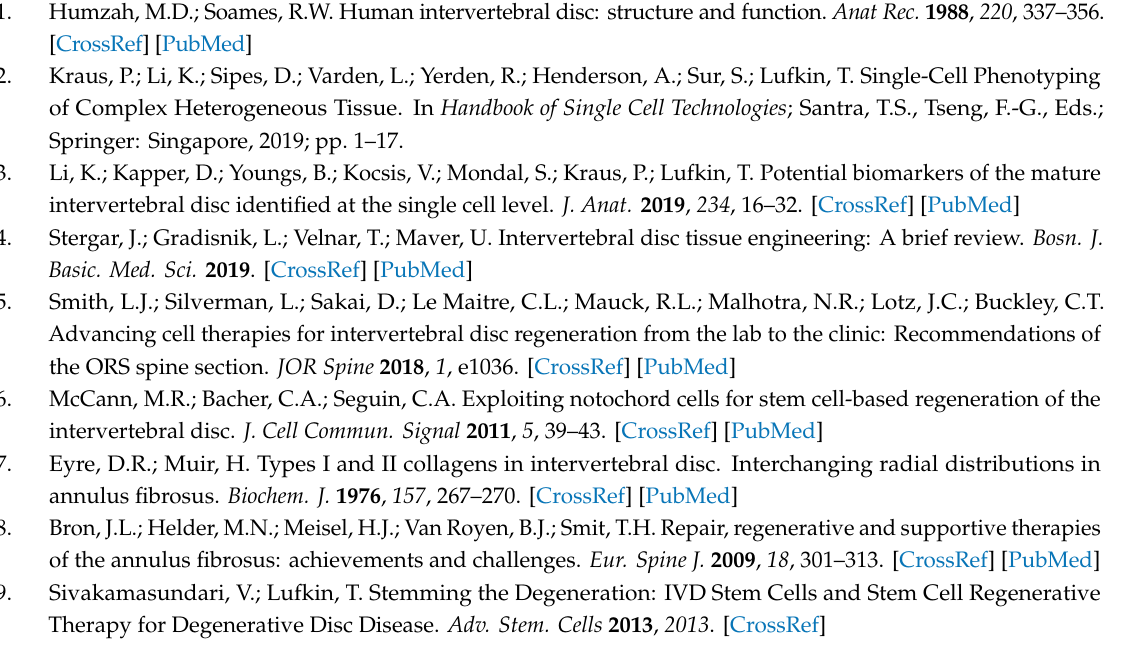
Figure S1: Kernel density estimates by intervertebral disc (IVD) for nine proposed biomarkers in (A) cells of the outer annulus fibrosus (AF) and (B) nucleus pulposus (NP) derived from three sections of a mature bovine IVD. Laminin1 ( Lam1 ); Thymocyte di ff erentiation antigen 1 ( Thy1 ); Glioma-associated oncogene 1 ( Gli1 ); Glioma-associated oncogene 3 ( Gli3 ); Notochord ( Noto ); Tyrosine phosphate receptor type C ( Ptprc ); Scleraxis ( Scx ); Sex determining region Y-box 2 ( Sox2 ); Zinc finger and SCAN domain containing ( Zscan10 ). Table S1: Data for the population average of transcript expression for nine proposed biomarkers in cells of the outer annulus fibrosus (AF) and nucleus pulposus (NP) of a mature bovine IVD. Laminin1 ( Lam1 ); Thymocyte di ff erentiation antigen 1 ( Thy1 ); Glioma-associated oncogene 1 ( Gli1 ); Glioma-associated oncogene 3 ( Gli3 ); Notochord ( Noto ); Tyrosine phosphate receptor type C ( Ptprc ); Scleraxis ( Scx ); Sex determining region Y-box 2 ( Sox2 ); Zinc finger and SCAN domain containing ( Zscan10 ). Table S2: Descriptive statistics and normality tests for total fluorescence and log-transformed total fluorescence for nine proposed biomarkers in cells of the outer AF and NP of a mature bovine IVD. Shapiro–Wilk tests reveal that log-transformed data is more normally distributed, while k-means clustering is implemented to fit the other data to a Gaussian mixture model. Cluster descriptive statistics are reported when data is not normally distributed. Laminin1 ( Lam1 ); Thymocyte di ff erentiation antigen 1 ( Thy1 ); Glioma-associated oncogene 1 ( Gli1 ); Glioma-associated oncogene 3 ( Gli3 ); Notochord ( Noto ); Tyrosine phosphate receptor type C ( Ptprc ); Scleraxis ( Scx ); Sex determining region Y-box 2 ( Sox2 ); Zinc finger and SCAN domain containing ( Zscan10 ). Table S3: Data for kernel density estimates by IVD for nine proposed biomarkers. Laminin1 ( Lam1 ); Thymocyte di ff erentiation antigen 1 ( Thy1 ); Glioma-associated oncogene 1 ( Gli1 ); Glioma-associated oncogene 3 ( Gli3 ); Notochord ( Noto ); Tyrosine phosphate receptor type C ( Ptprc ); Scleraxis ( Scx ); Sex determining region Y-box 2 ( Sox2 ); Zinc finger and SCAN domain containing ( Zscan10